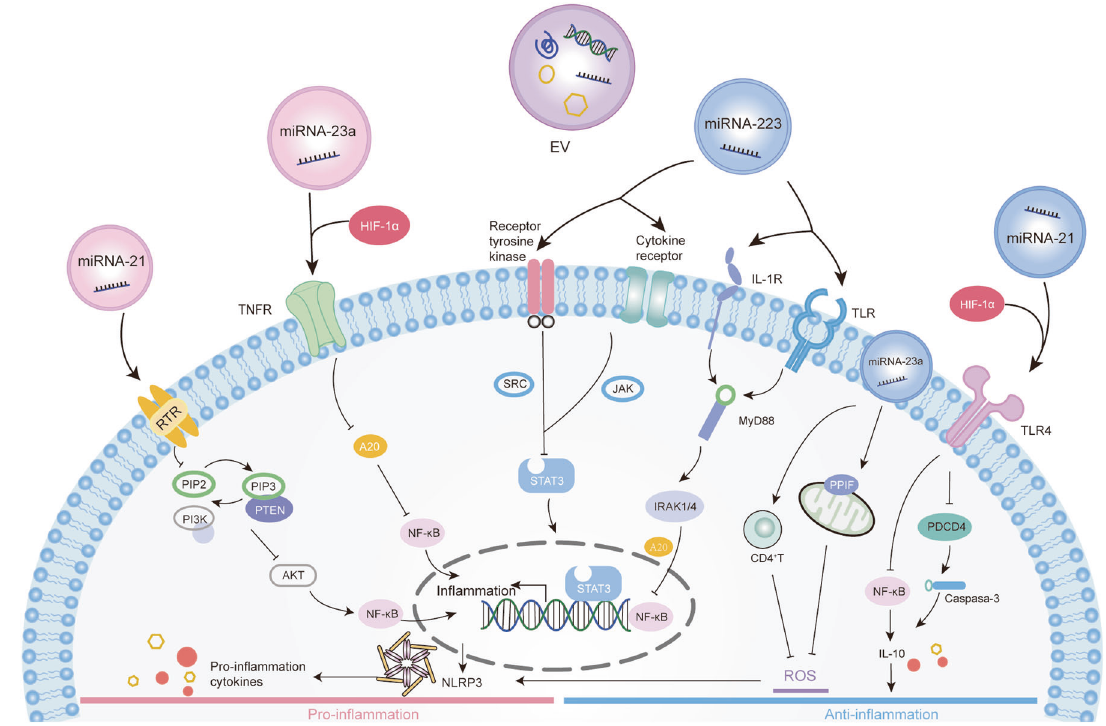
Fig. 4 Mechanisms involved in the modulation of in fl ammation by miRNA derived EVs. In response to hypoxia, cells release extracellular vesicles (EVs) containing miRNAs, which regulate in fl ammatory signals. These signals can be detected by speci fi c recognition receptors, thus altering the state of in fl ammation by affecting the associated signaling pathways and their downstream immune cell activation. MiR-223 can inhibit classical pro-in fl ammatory pathways through NF- κ B and STAT3 pathway and enhances anti-in fl ammatory responses. It can suppress in fl ammation via inhibition of NLRP3 in fl ammasome activation. Under hypoxia conditions, the expression of miR-223 was downregulated and the anti-in fl ammatory effect was weakened. miR-23a-enriched exosomes mediated via HIF-1 α that activate proin fl ammatory macrophages by inhibiting A20 target to NF- κ B. It also can suppress reactive oxidative stress (ROS) and curbs necrosis by targeting peptidylprolyl isomerase F (PPIF). MiR-23a is essential for the proliferation of effector CD4 + T cells and prevent tissue necrosis caused by ROS. MiR-21 plays an anti- in fl ammatory effect by inhibiting NF- κ B and PDCD4/caspase-3 pathway. Conversely, miR-21 also participates in the positive feedback loop of in fl ammation through the in fl ammatory signals of NF- κ B and STAT3 factor in tumor